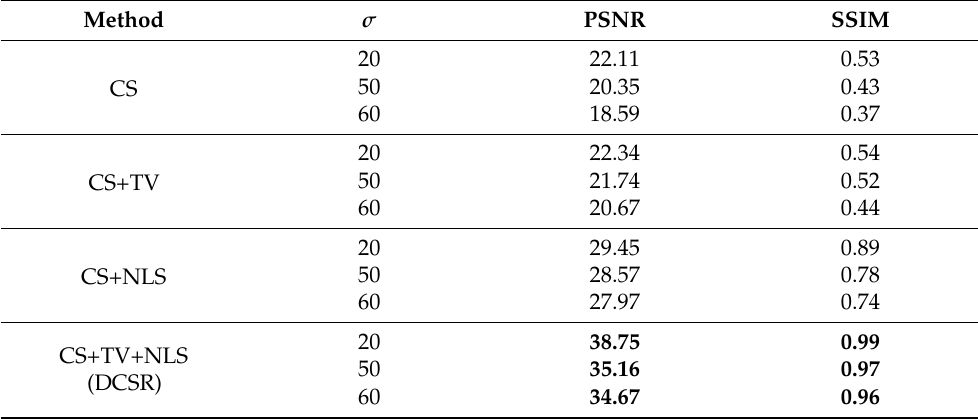
Table 3. Ablation